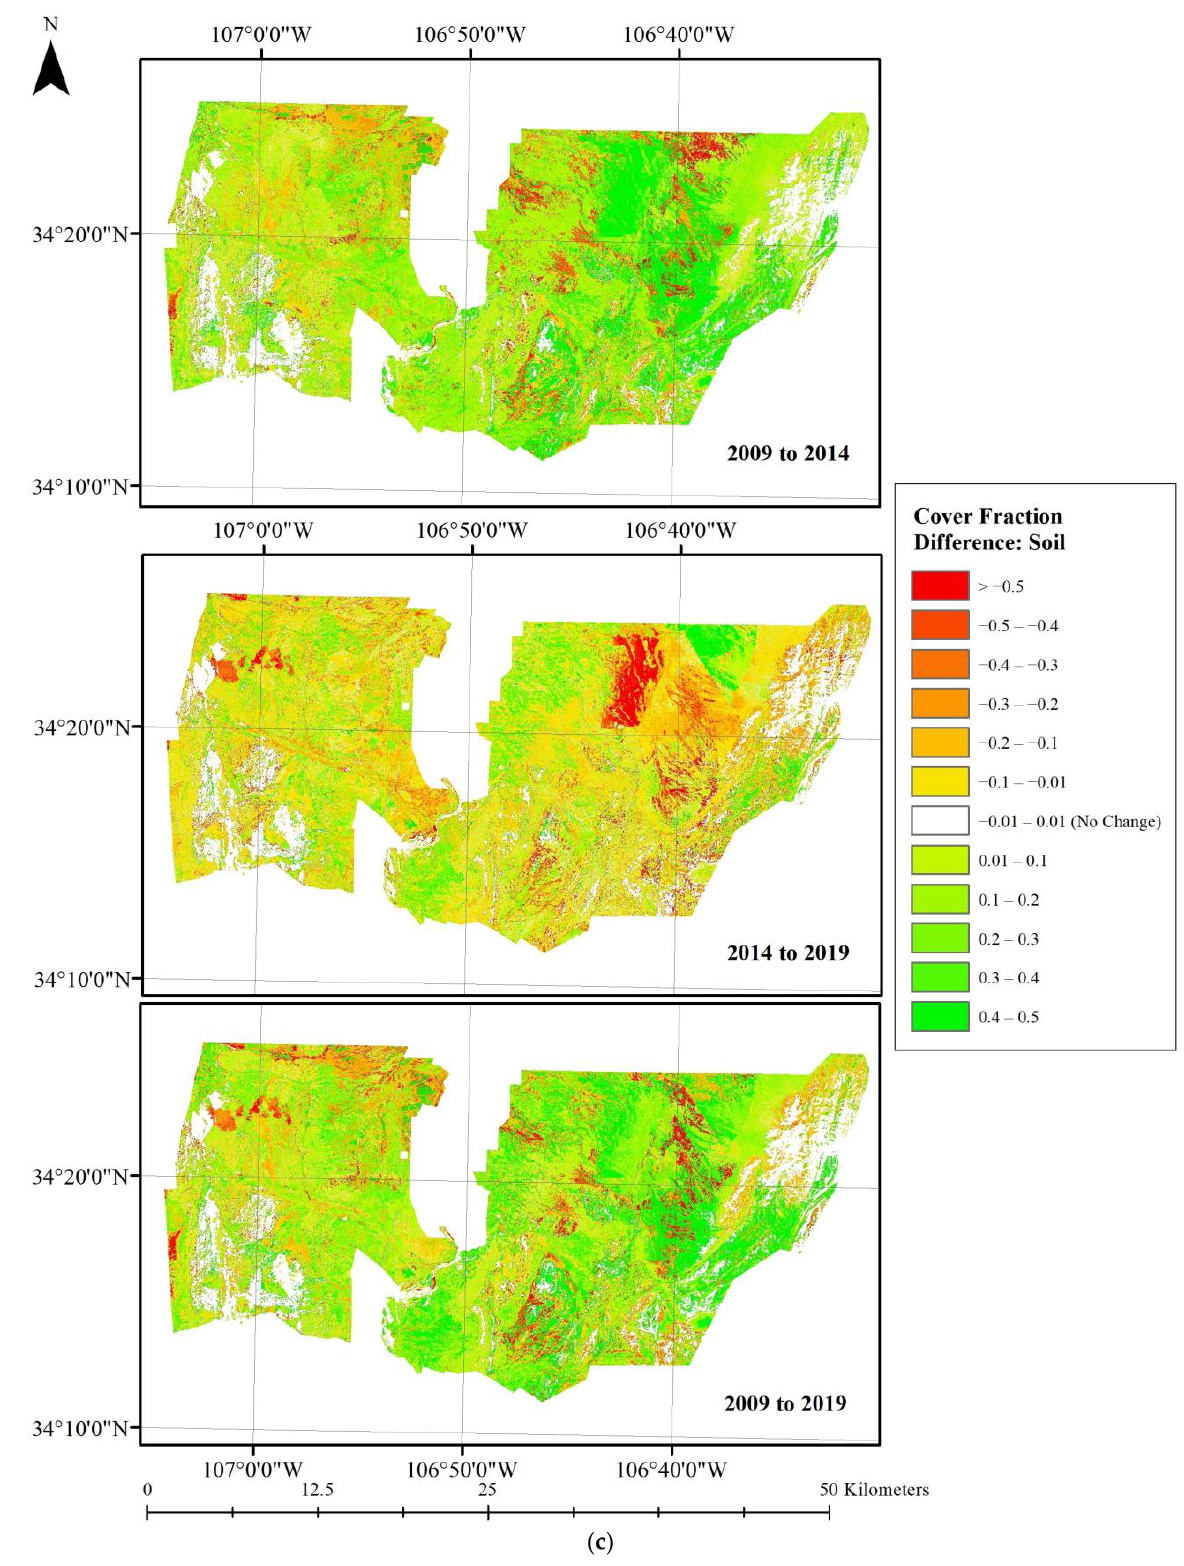
Figure 6. Map of differences in fractional cover over the drought and recovery period, 2009–2019. Results are divided by cover class: ( a ) NPV, ( b ) GV, and ( c ) soil. The map in the first subset row in each subfigure represents 2009–2014 (drought period); second row 2014–2019 (recovery period); and third row 2009–2019 (drought + recovery period). White indicates no change; green indicates a positive difference from baseline; red indicates a negative difference from